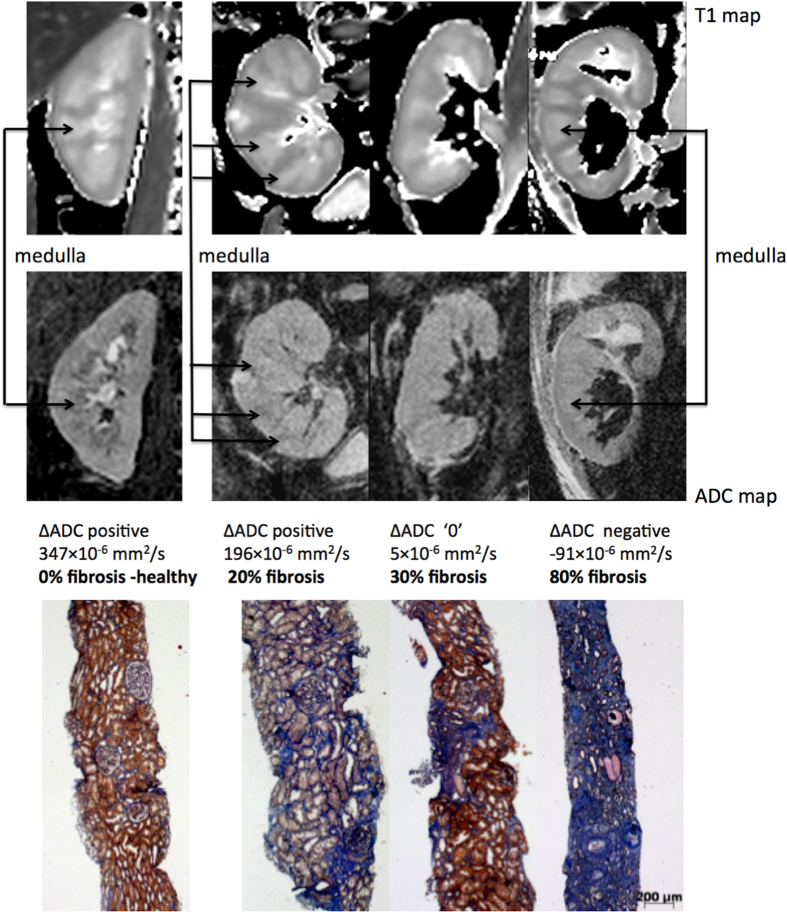
Representative biopsy and MR images patients.Morphological MOLLI T1 map used for the positioning of the regions of
interest (top row) and ADC maps (lower row) for 3 patients showing the
different ΔADC cases: positive, zero and negative; along with
the corresponding fibrosis levels from histology (Masson trichrome
staining).